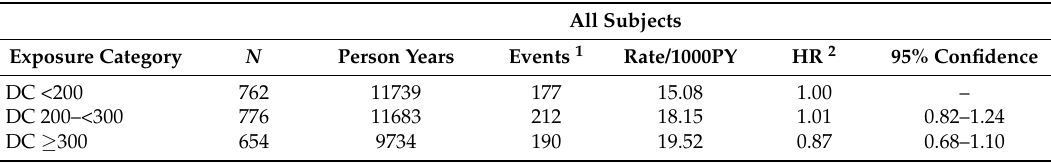
Table 2. Rates and adjusted hazard ratios for incident T2DM or IFG according to dietary cholesterol intake.